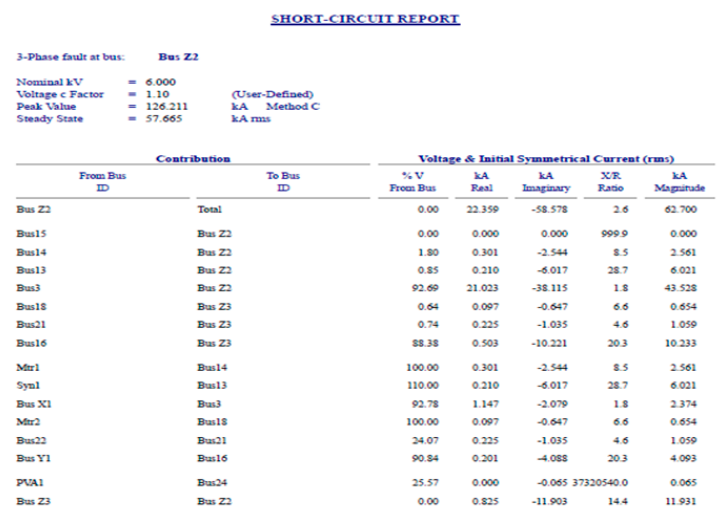
Figure 14. Short-circuit report: three-phase fault at bus Z2.